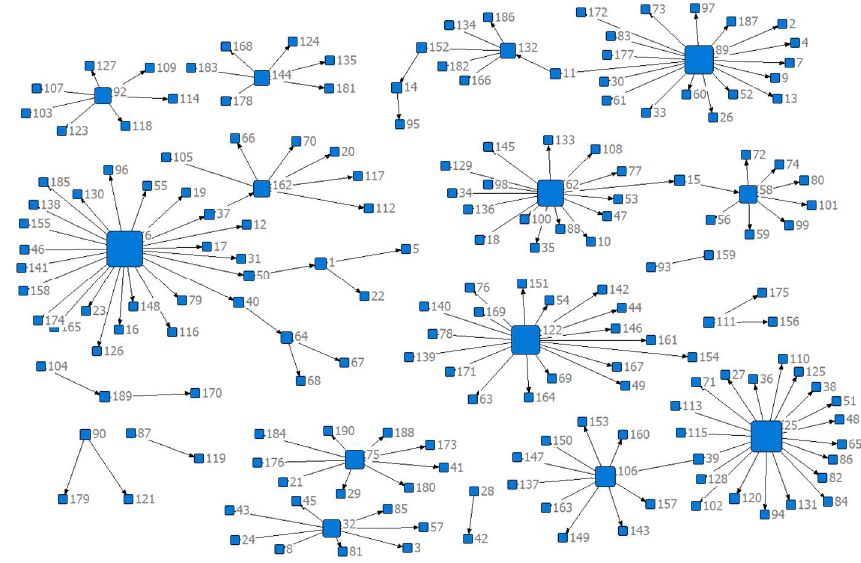
Figure 4. Inter-actor spinoff network of ecological agriculture.